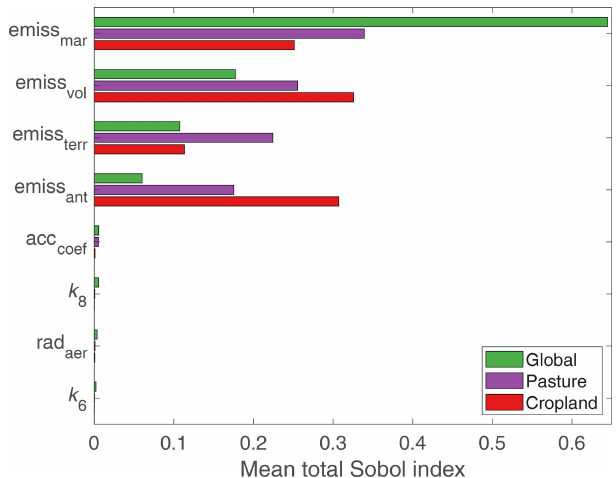
Figure 11. Bar plot summarizing the importance of the input param- eters to total Se deposition globally and in agricultural areas. For the cropland and pasture means, Sobol’ indices are averaged over grid boxes that are covered by more than 25% cropland or pasture area in the Ramankutty et al. (2008)